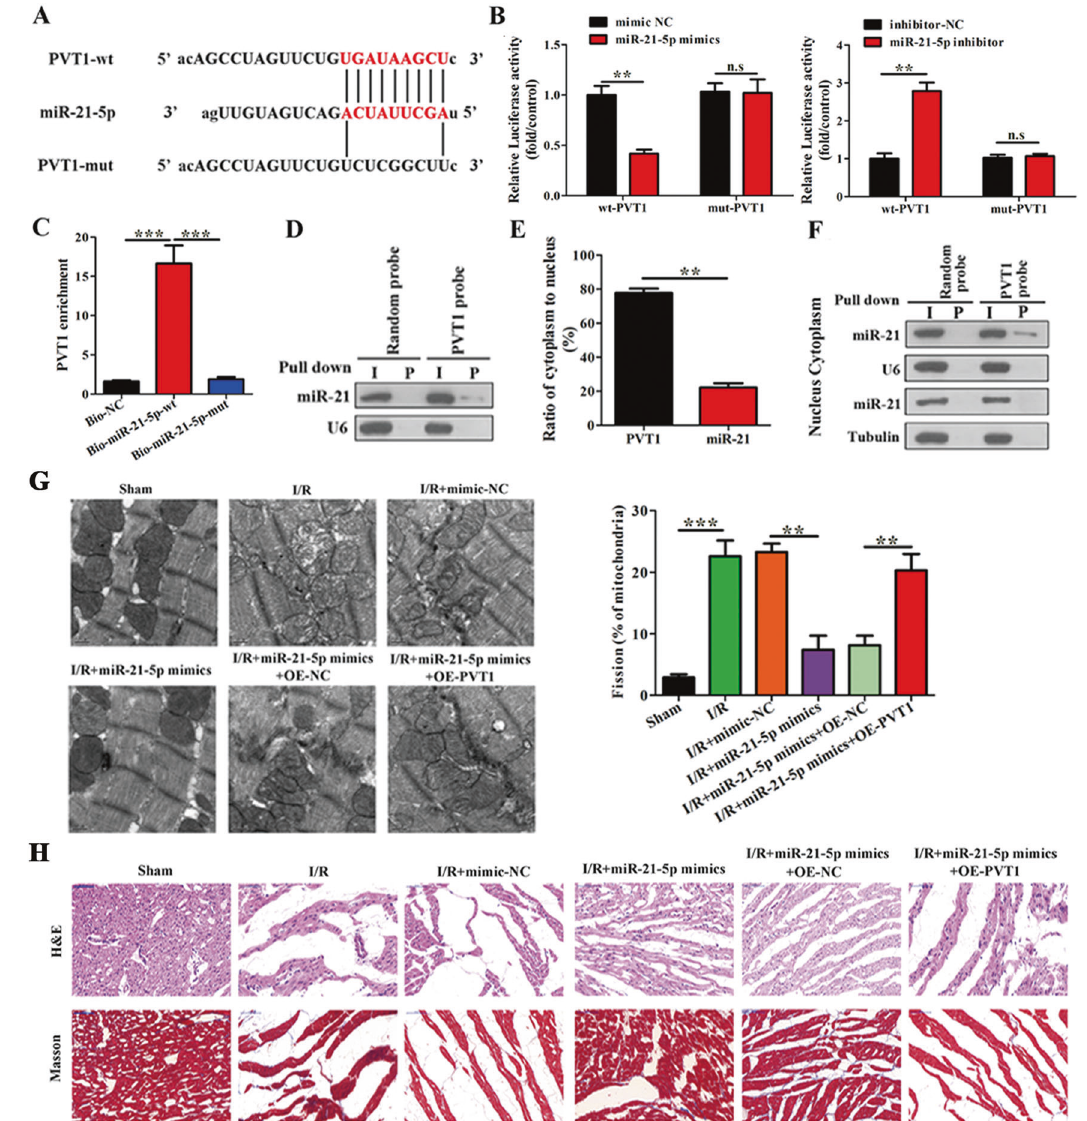
inhibitor, and PVT1-wt or PVT1-mut ( n = 3). C Cardiomyocytes were transfected with biotinylated WT miR-21-5p (Bio-miR-21-5p-wt) or biotinylated mutant miR-21-5p (Bio-miR-21-5p-mut). A biotinylated miRNA that was not complementary to PVT1 was used as the normal control (Bio-NC). 48 h post transfection, the cells were harvested for a biotin-based pull-down assay and PVT1 expression levels were analyzed by qRT-PCR ( n = 3). D Representative northern blot evaluating expression of miR-21-5p in random or in PVT1 DNA probe pull-down fractions ( n = 3). E , F Detection of nuclear or cytoplasmic fractions of PVT1 and miR-21-5p in cardiomyocytes was determined by northern blotting. Tubulin and proliferating cell nuclear antigen (PCNA) were used as controls for cytoplasmic and nuclear fractions, respectively ( n = 3). G Representative TEM images of heart tissues under different conditions of miR-21-5p mimic treatment and PVT1 overexpression (OE-PVT1). Quanti fi cation of fragmented mitochondria is shown in the right panel (Scale bar = 0.5 μ m) ( n = 6). H Representative images of H&E and Masson ’ s trichrome staining of LV sections (Scale bar = 50 μ m) ( n = 3). ** P < 0.01; *** P <